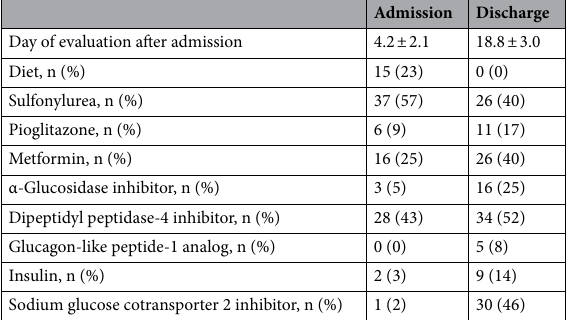
(Table 4). The analysis identified hypoglycemia to be significantly associated with high L_RHI (p = 0.019). The odds for normal vascular endothelial function were 0.08 times lower with each 1-point increase in hypoglycemia (95% confidence interval, 0.01–0.67). Univariable and multivariable linear regression analyses were performed to estimate the regression coef- ficients for change in vascular endothelial function. The results identified hypoglycemia during educational hospitalization as a significant determinant of changes in L_RHI (Supplemental Table 3). In fact, the change in